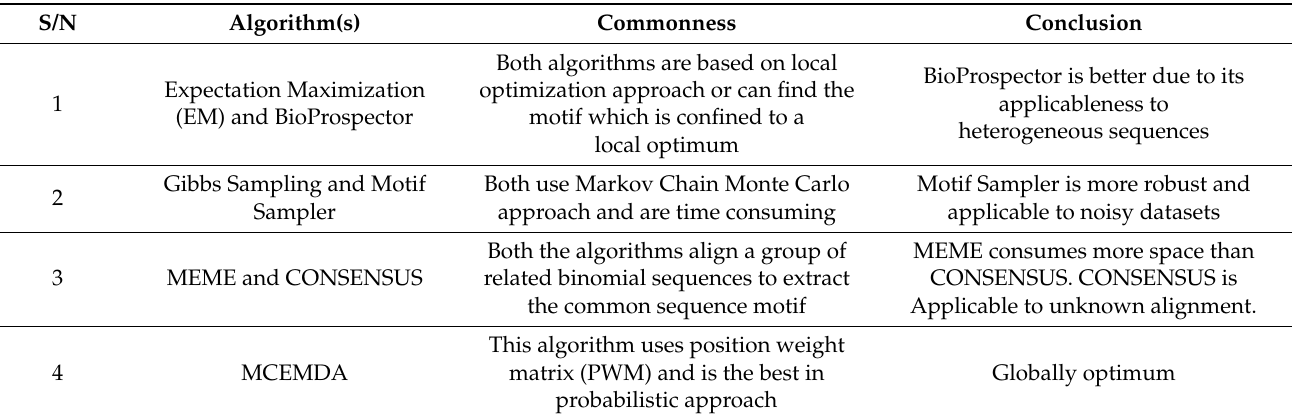
Table 1. Summary of Motif Discovery Algorithms based on Probabilistic